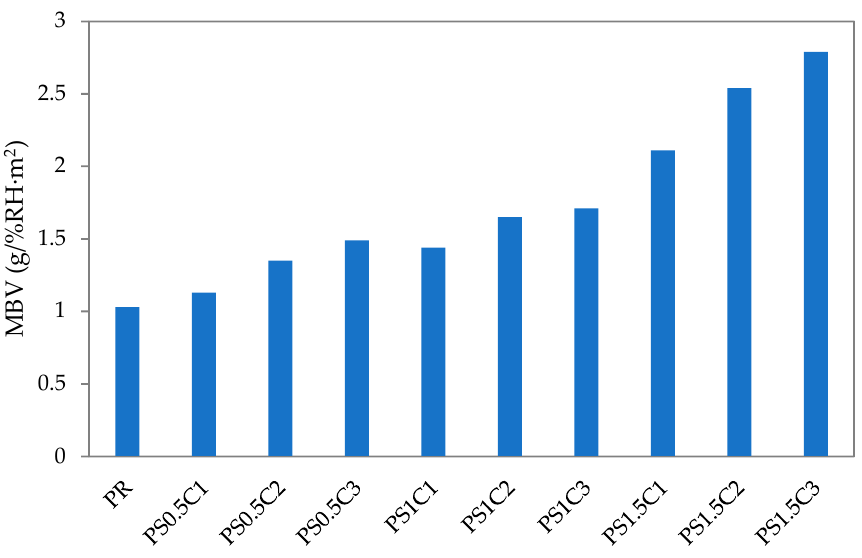
Figure 6. Moisture buffer value of modified plasters.